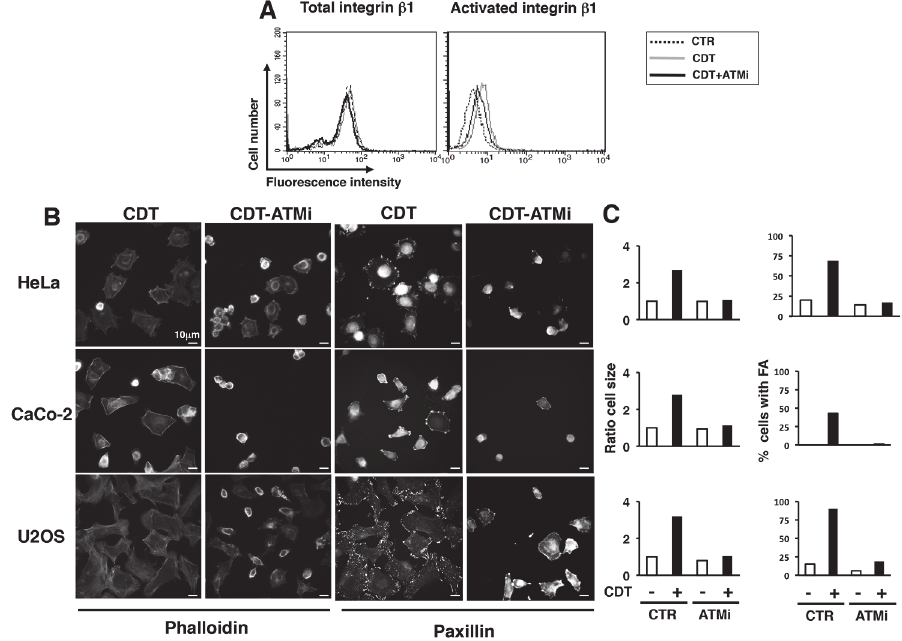
Fig 5. Integrin β 1 activation and enhanced spreading in intoxicated cells is dependent on the DNA damage sensor kinase ATM. A. HeLa cells were left untreated (CTR, dotted line), intoxicated (1 μ g/ml for 24h, CDT, grey line) or pre-incubated with the ATM inhibitor KU-55933 (5 μ M, ATMi, black line) prior intoxication. Surface expression of the integrin β 1 total levels (left panel) or its activate form (right panel) was assessed by FACS analysis. B. Analysis of cell spreading and formation of focal adhesions was performed in HeLa, CaCo2, and U2OS cells, pre-incubated with the ATM inhibitor as described in A. The panel shows representative micrographs of intoxicated cells left untreated (CDT) or pre-incubated with the ATM inhibitor (CDT-ATMi). The actin cytoskeleton was visualized by phalloidin staining and focal adhesion complexes